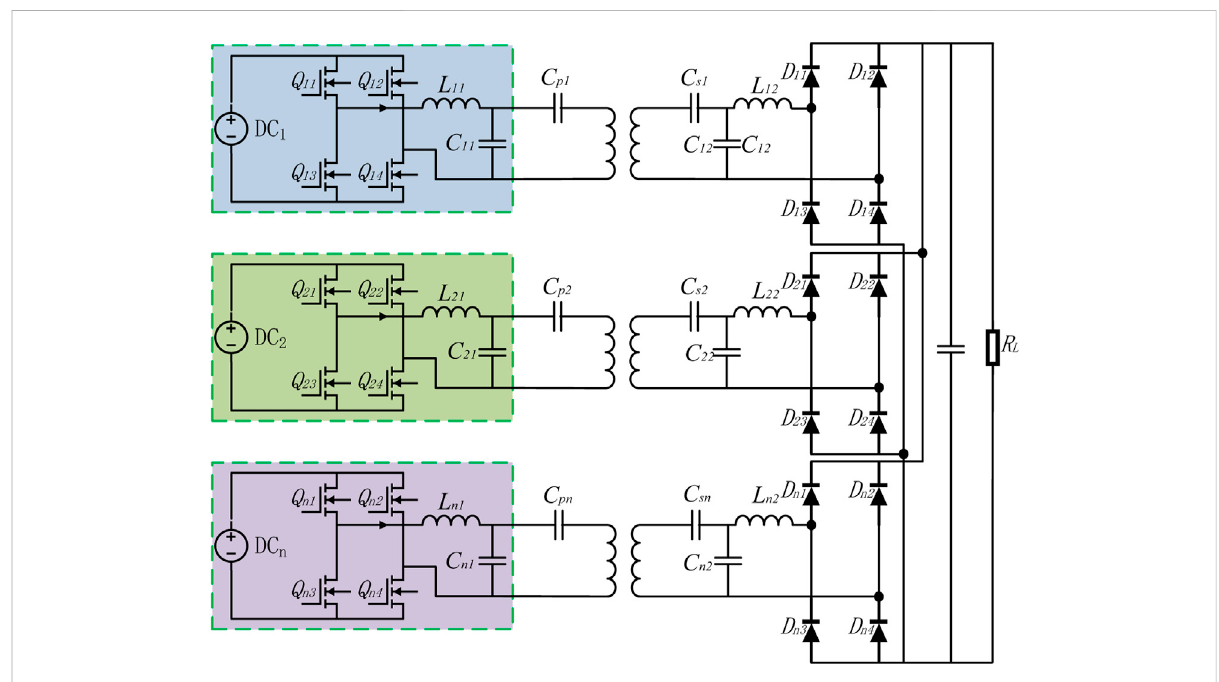
FIGURE 1 MTMR WPT system with DS-LCC compensation